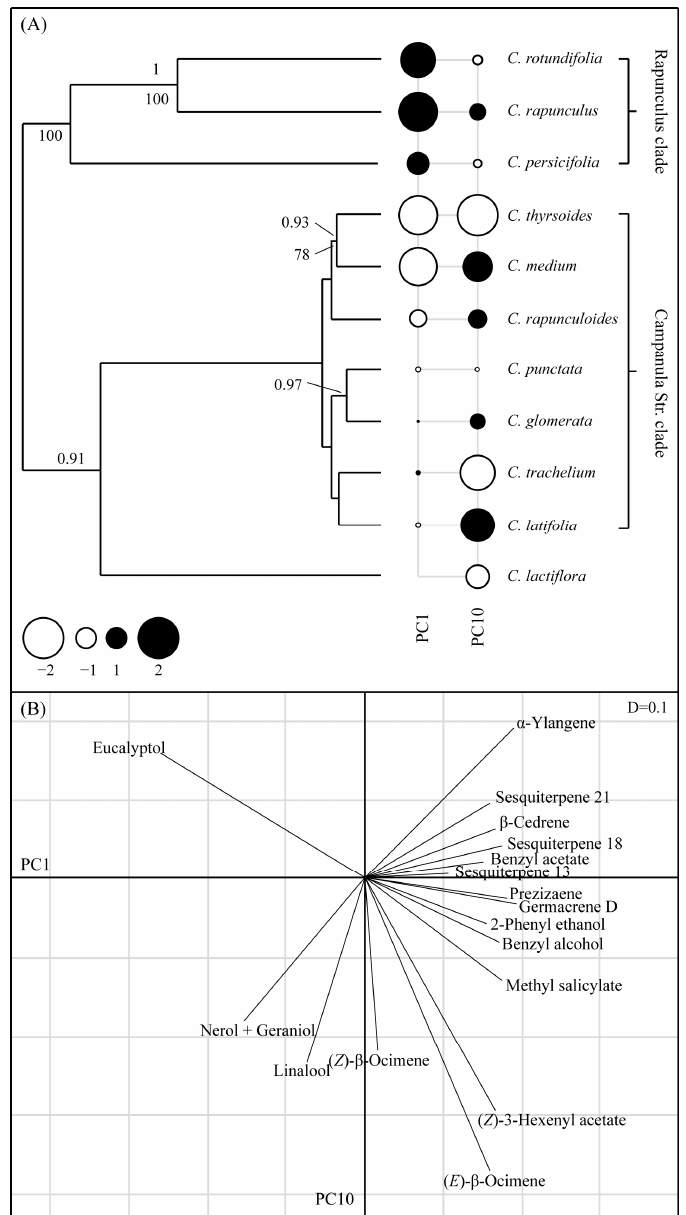
Figure 4. ( A ) Phylogeny of the species studied and results of the scent pPCA. Positive and negative scores on PC1 (global) and PC10 (local) are indicated by black and white circles, respectively. Symbol sizes are proportional to absolute values. Bayesian posterior probabilities (BPP) ≥ 0.95 and ML bootstrap values ≥ 70% are indicated above and below branches, respectively. ( B ) Loading of the main traits for the global (horizontal axis) and local (vertical axis) principal components. Only the compounds with the highest loadings on the PCs are depicted. The loadings of all variables and scores of each species are provided as Supplementary Material (Tables S5 and S6,